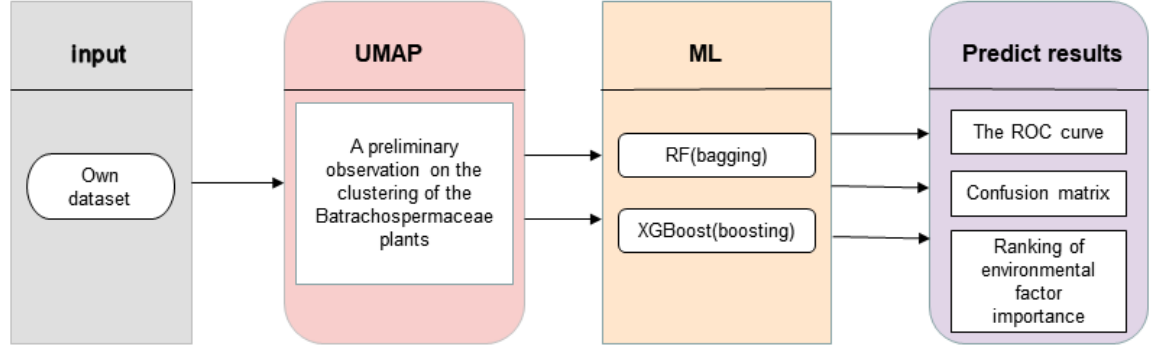
Figure 6. Method block diagram of this study [36].